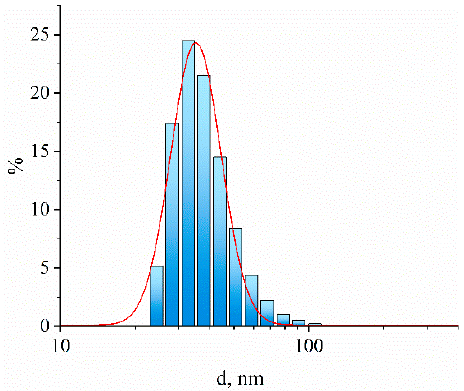
Figure 1. The example of hydrodynamic size distribution obtained by dynamic light scattering and fit to the log-normal distribution for Prussian Blue nanoparticles with the average diameter of 35